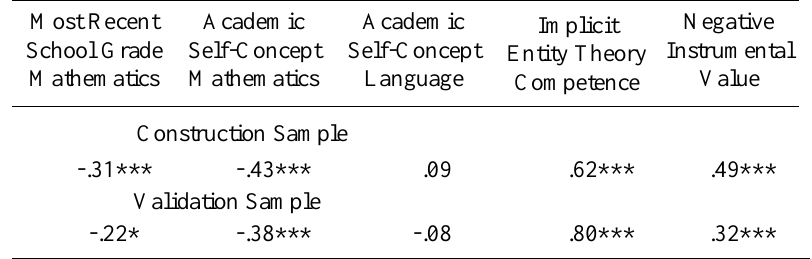
Relations of WAESTA sum scores with background and self-belief variables (zero- order correlations): Results from the construction and the validation sample Most